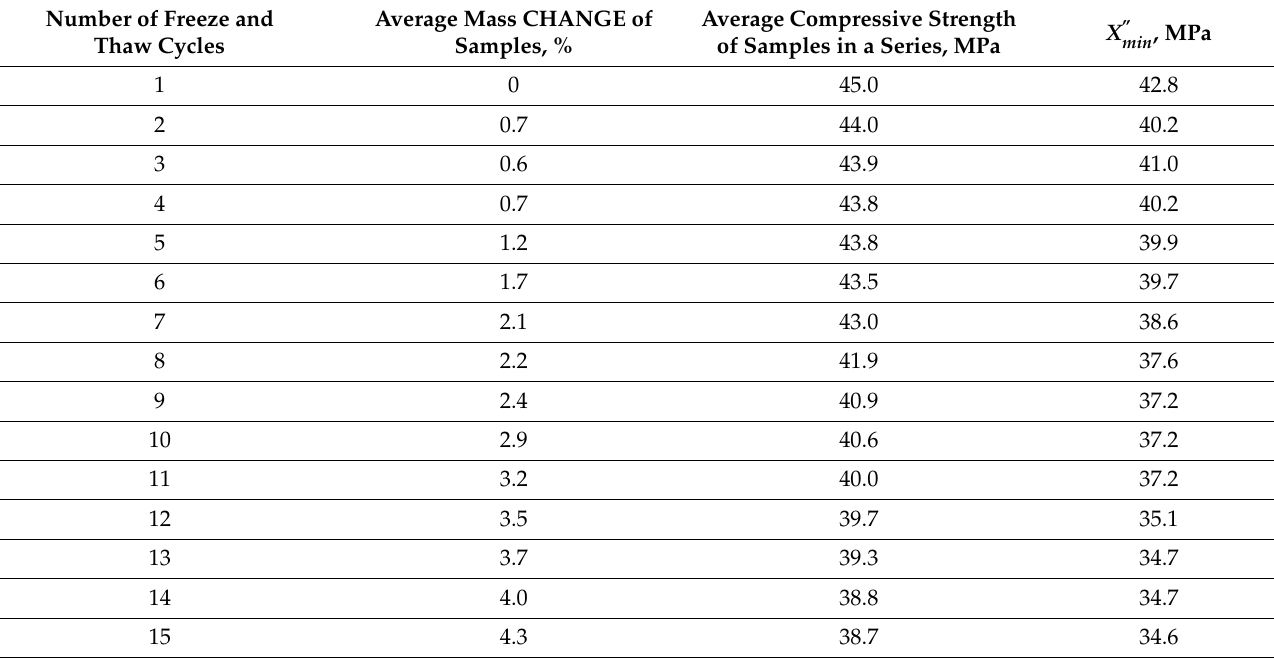
Table 9. Test results of vibrated samples subjected to alternate freezing and thawing.